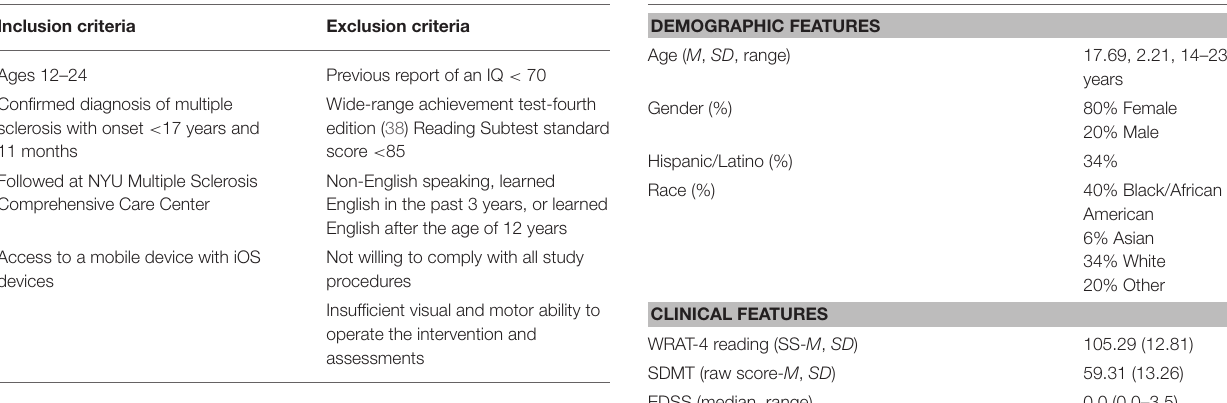
TABLE 1 | Inclusion and exclusion criteria. TABLE 2 | Demographic and clinical features ( N =